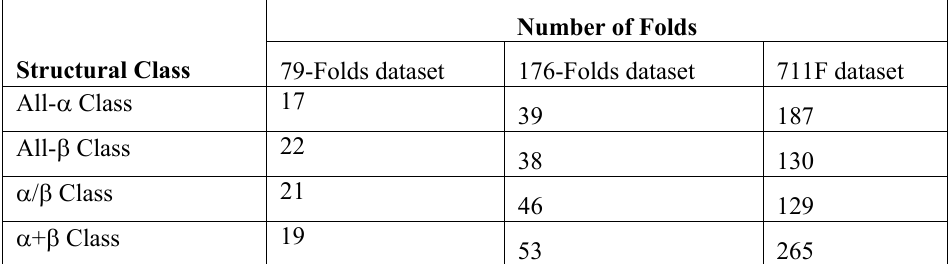
Table 2: Distribution of protein folds in four major SCOP structural classes in three different